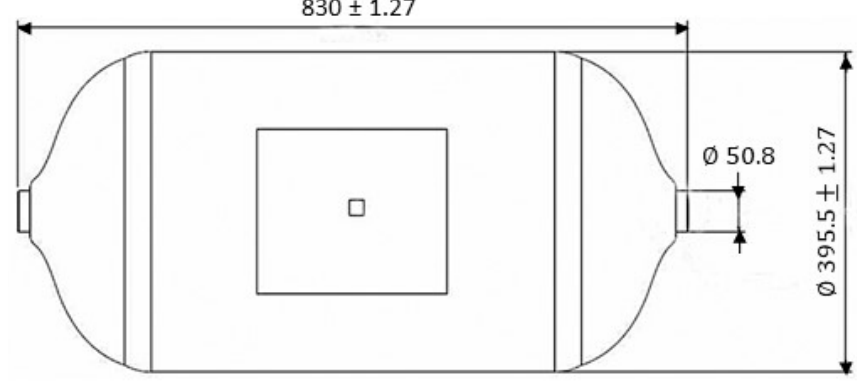
Figure 4. Geometry of the type III CNG cylinder considered for the model validation [20].